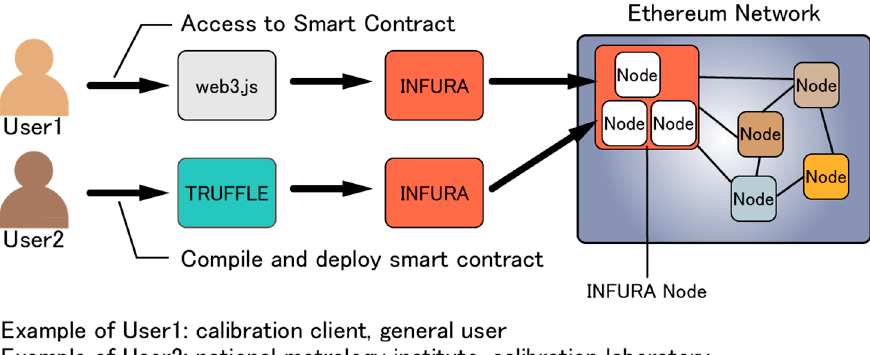
Figure 2. Method of creating and using smart contracts in this study.